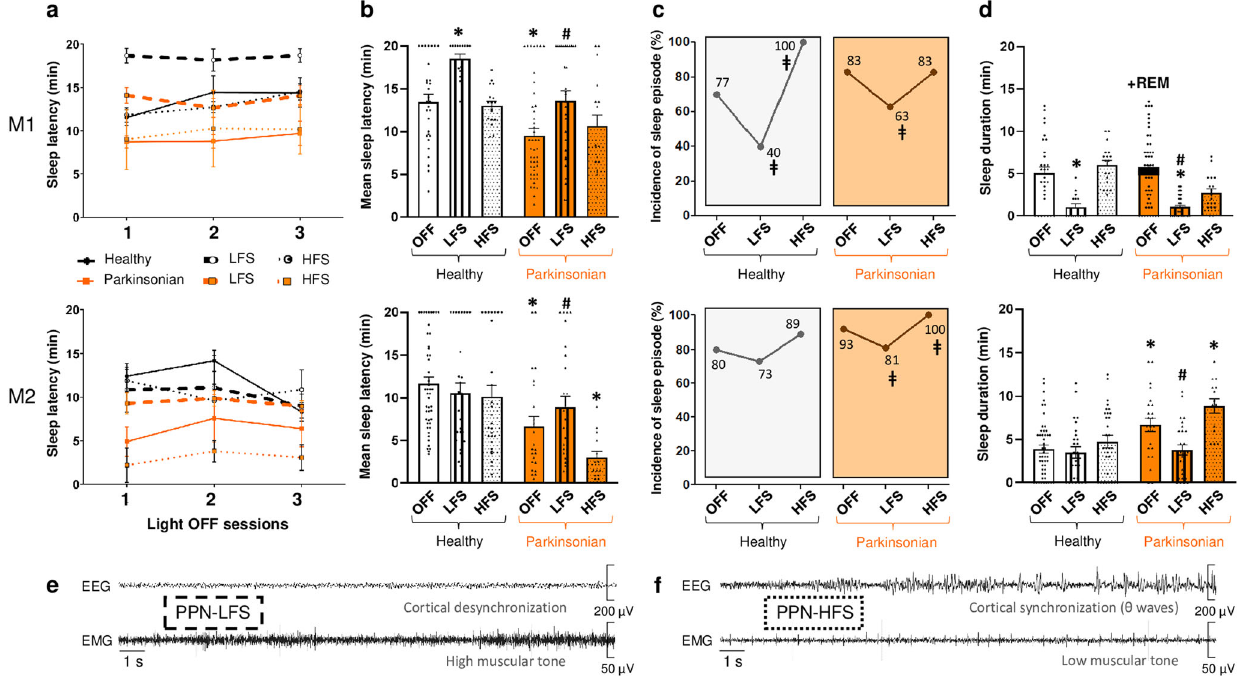
Fig. 2 Panel of different sleep parameters obtained from mMSLTs. Sleep parameters were obtained in light-OFF sessions for each animal M1 and M2, OFF-stimulation versus ON-stimulation conditions in healthy (white) and parkinsonian (orange) states with low-frequency stimulation (LFS, vertical lines) and high-frequency stimulation (HFS, dots). a Sleep latency, expressed in minutes (mean ± SEM), for each light- OFF session (1) from 10:00 h to 10:20 h, (2) from 11:00 h to 11:20 h, (3) from 12:00 to 12:20 h for healthy (black line) and parkinsonian (orange line) states with LFS (bold dotted line) and HFS (thin dotted line), b Mean time of sleep latency, expressed in minutes (mean ± SEM), for all light-OFF sessions pooled together by condition, p < 0.05 * different from healthy OFF-stimulation; # different from parkinsonian OFF- stimulation: Kruskal – Wallis test followed by Dunn ’ s multiple comparisons test. c Occurren c e of at least 30 seconds of sleep during all light-OFF sessions, expressed in %, p < 0.05 ǂ different from OFF-stimulation: Fisher ’ s exact test. d Mean time of sleep duration, expressed in minutes (mean ± SEM), for all light-OFF sessions pooled together by condition. Note in M1 parkinsonian condition the appearance of small episodes of REM sleep materialized in black on the histogram. p < 0.05 * different from healthy OFF-stimulation; # different from parkinsonian OFF- stimulation: Kruskal – Wallis test followed by Dunn ’ s multiple comparisons test. e Typical 30-s example of EEG and EMG tracings showing cortical desynchronization associated with high muscle tone observed in PPN-LFS condition and, f cortical synchronization associated with low muscle tone observed in PPN-HFS